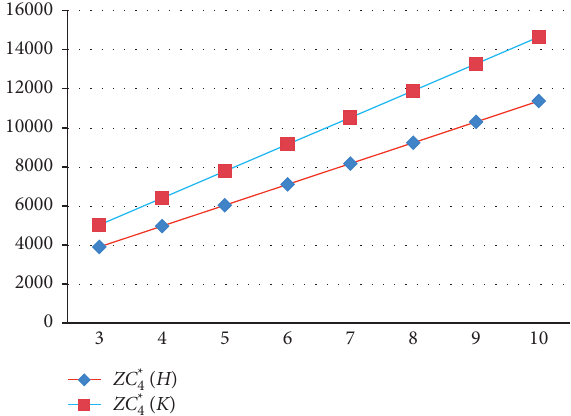
Figure 8: Comparison of ZC ∗ dimensions 3 ≤ n ≤ 10.